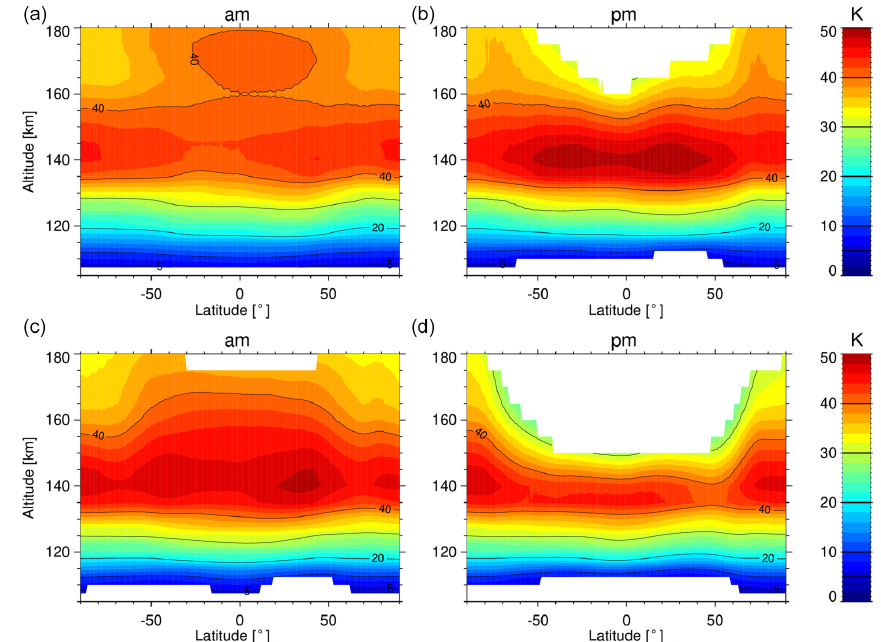
Figure 8. The noise component of the UA temperature retrieval error in the lower thermosphere as a function of latitude and altitude, separated for (a, c) morning and (b, d) afternoon as well as for high-solar-activity conditions (averaged over the years 2005, 2006, 2011, and 2012, a, b ) and low-solar-activity conditions (averaged over the years 2007–2010, c, d ). White areas indicate data with insignificant information content (AK diagonal <